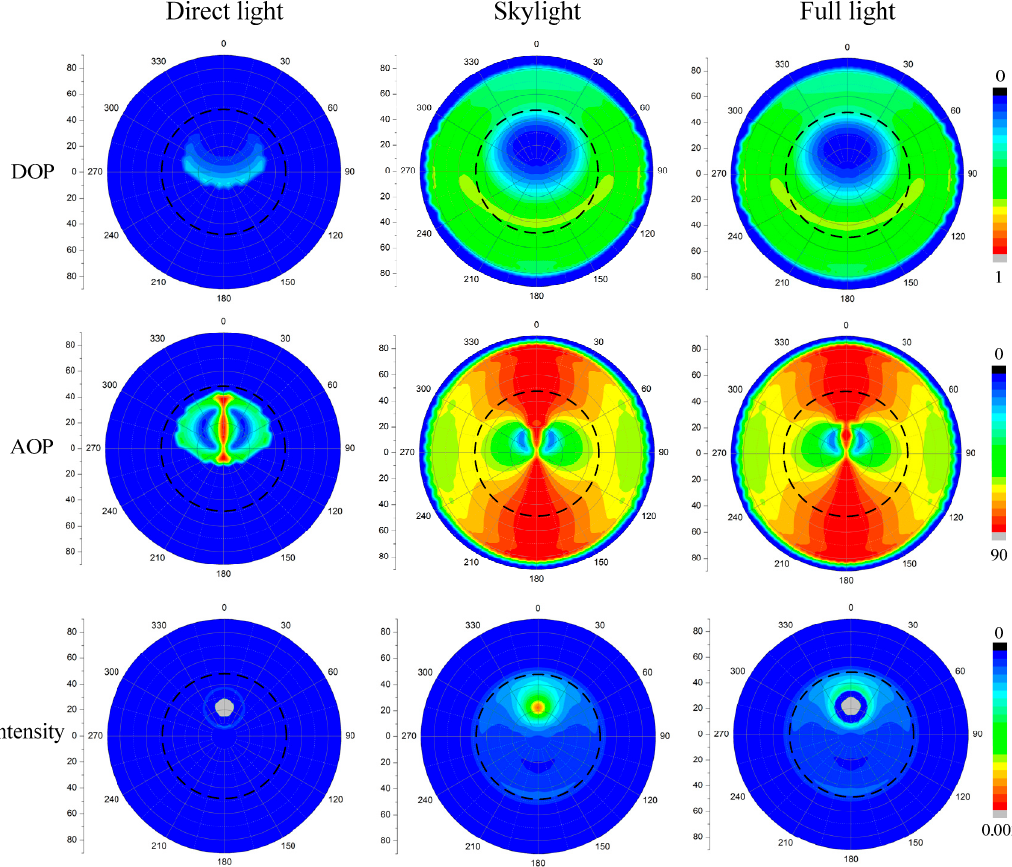
Figure 11. The DOP, AOP and intensity patterns of transmitted light under a wavy water surface with different incident sources (the direct solar light, scattering skylight and combination of above), where the SZA is 30°, wind speed is 5m/s, and wind direction is 0°.